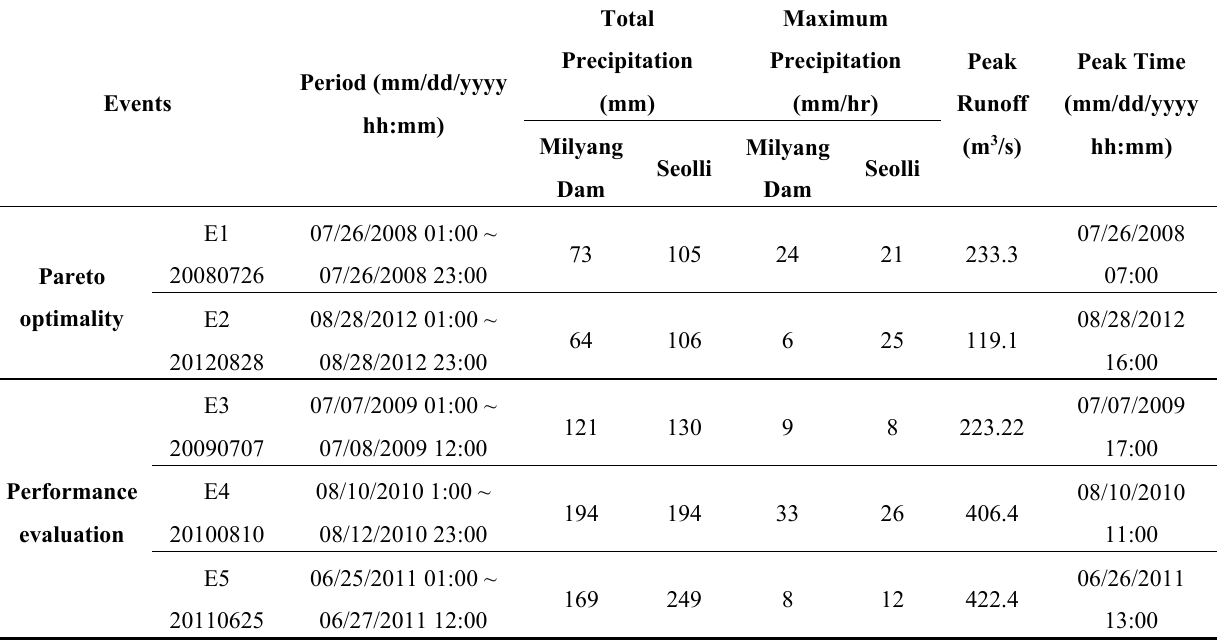
Table 1. Description of each